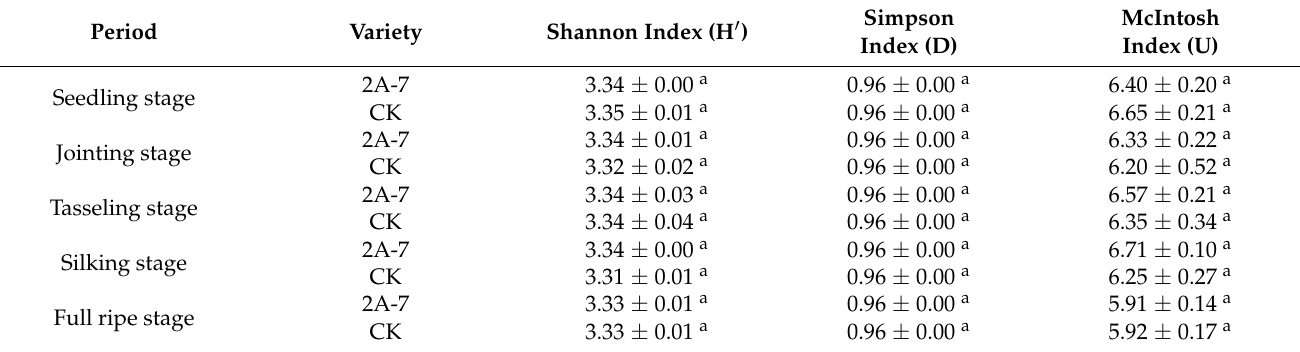
Table 2. Comparison of metabolic functional diversity indices of microbial communities in rhizo- sphere soils of transgenic maize 2A-7 and its non-transgenic control during different developmen- tal